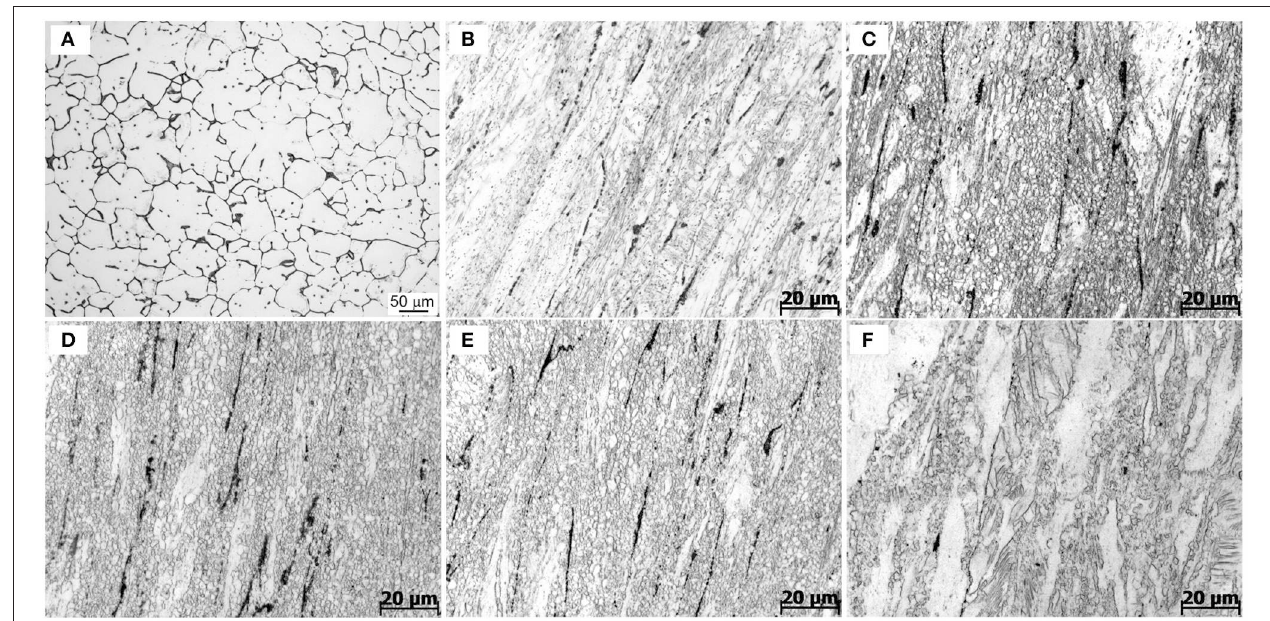
FIGURE 5 | Optical images of the Mg-2.0Zn-0.5Zr-3.0Gd alloys: (A) As-cast; (B) E330; (C) E340; (D) E350; (E) E360; and (F) E370.